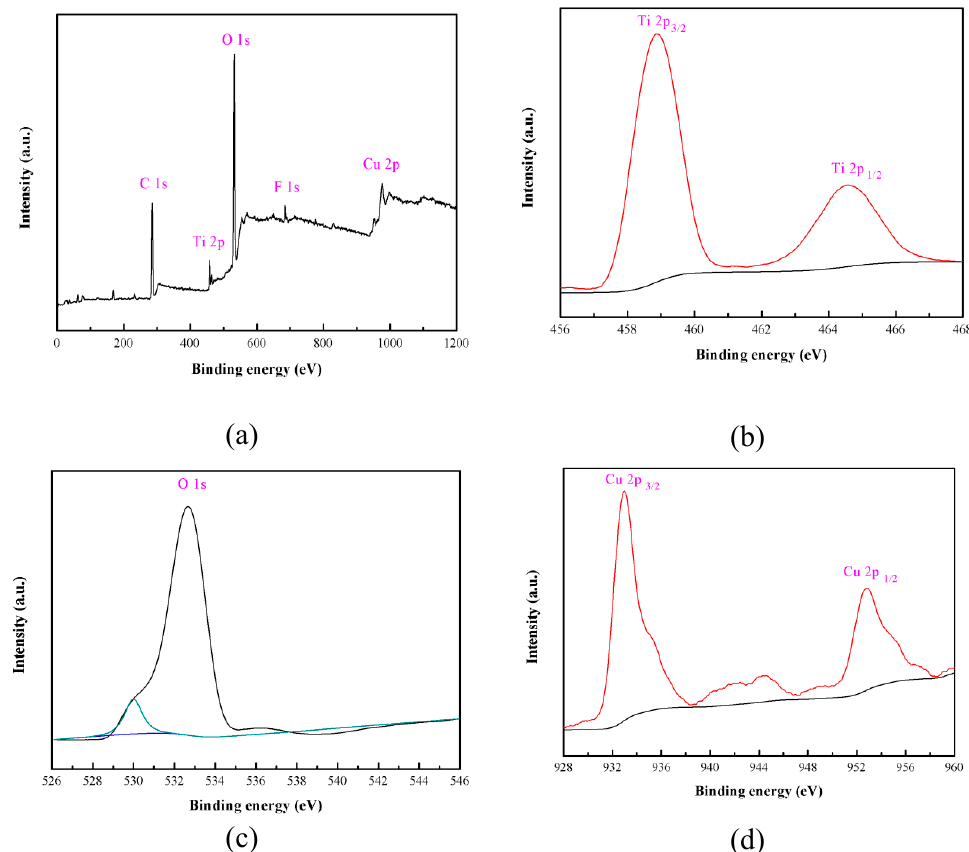
Figure 7. XPS spectra of the as-prepared Cu 2 O/(001)TiO 2 sample: ( a ) survey spectrum, ( b ) Ti 2p spectrum, ( c ) O 1s spectrum and ( d ) Cu 2p spectrum.